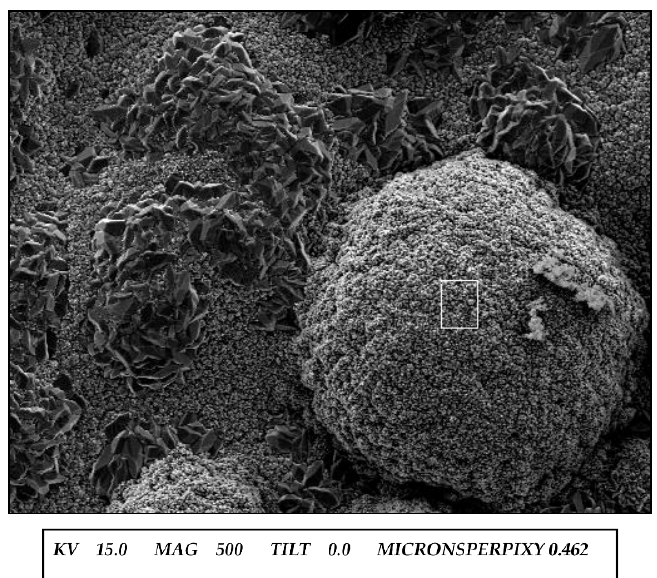
Figure 2. Cr 2 Nb alloy microanalysis.